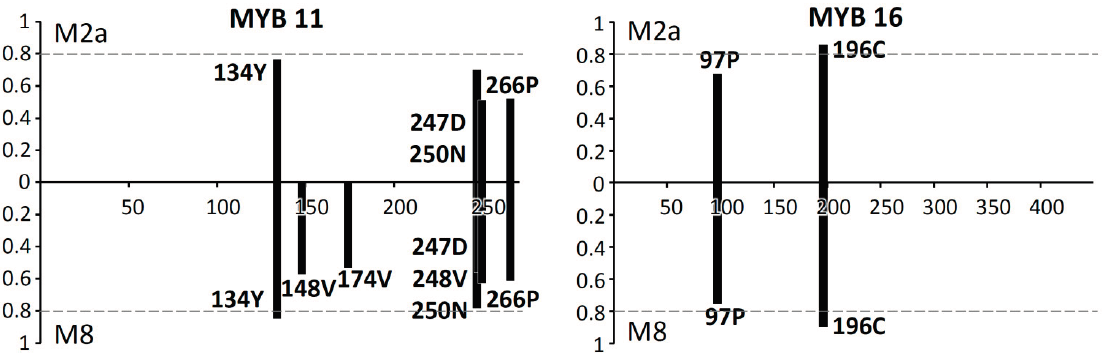
Figure 2. Site-specific profile of the positive selection site models M2a and M8 in MYB11 and MYB16 . Horizontal dot line indicates the criterion of posterior probability